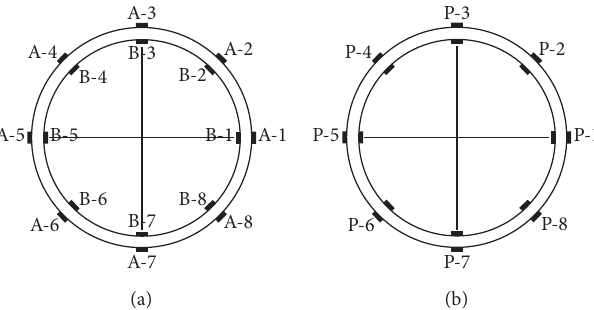
Figure 5: (a) Arrangement of strain gauges. (b) Arrangement of earth pressure